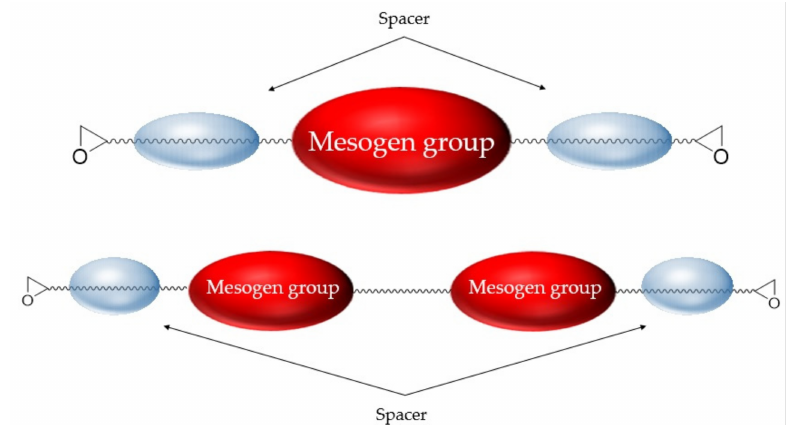
Figure 2. Typical molecular structure of liquid crystalline epoxy resin.